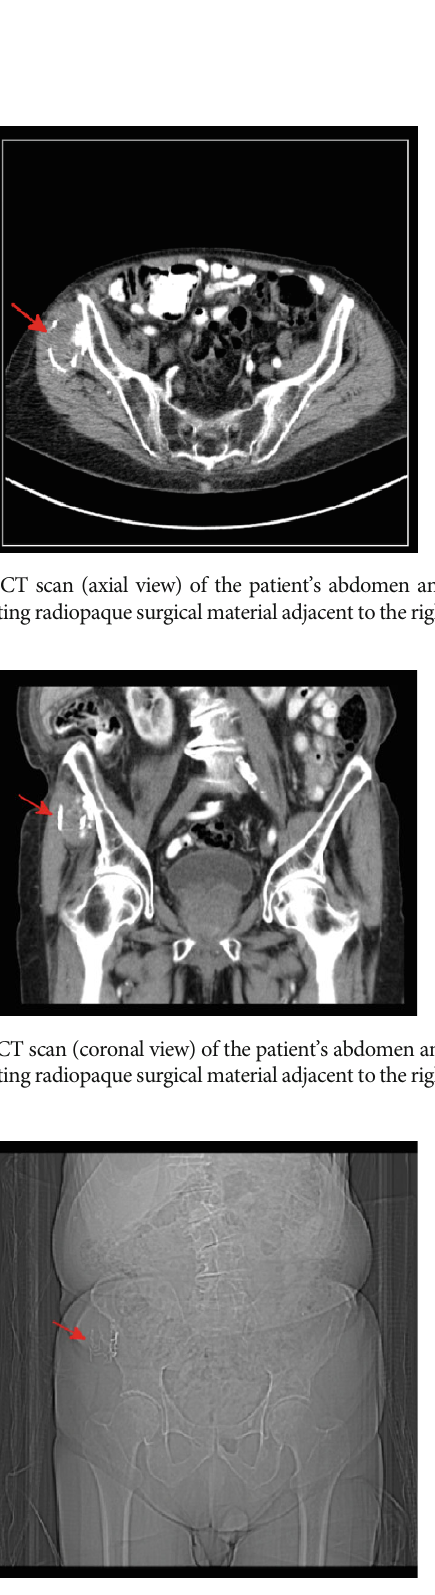
Figure 3: CT scan (scout image) demonstrating radiopaque strings in the patient ’ s right hip.